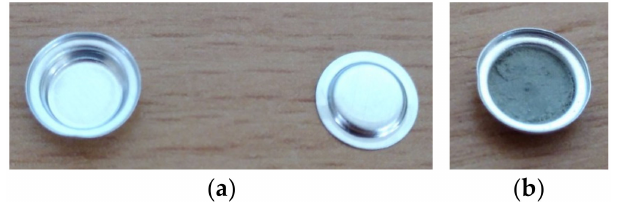
Figure 3. ( a ) Aluminum crucible and lid; ( b ) crucible filled with drill core